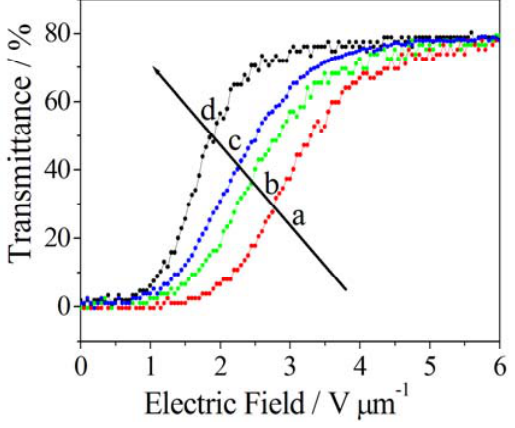
Figure 29. Electric field dependent transmittance as a function of applied UV power: ( a ) 0 mW/cm 2 , ( b ) 2.5 mW/cm 2 , ( c ) 5 mW/cm 2 , and ( d ) 10 mW/cm 2